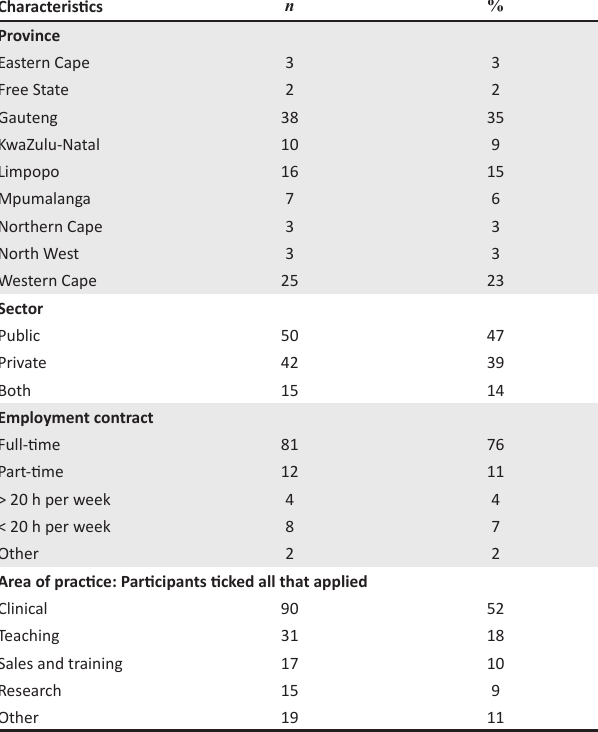
TABLE 2: Employment demographics within audiology ( n =